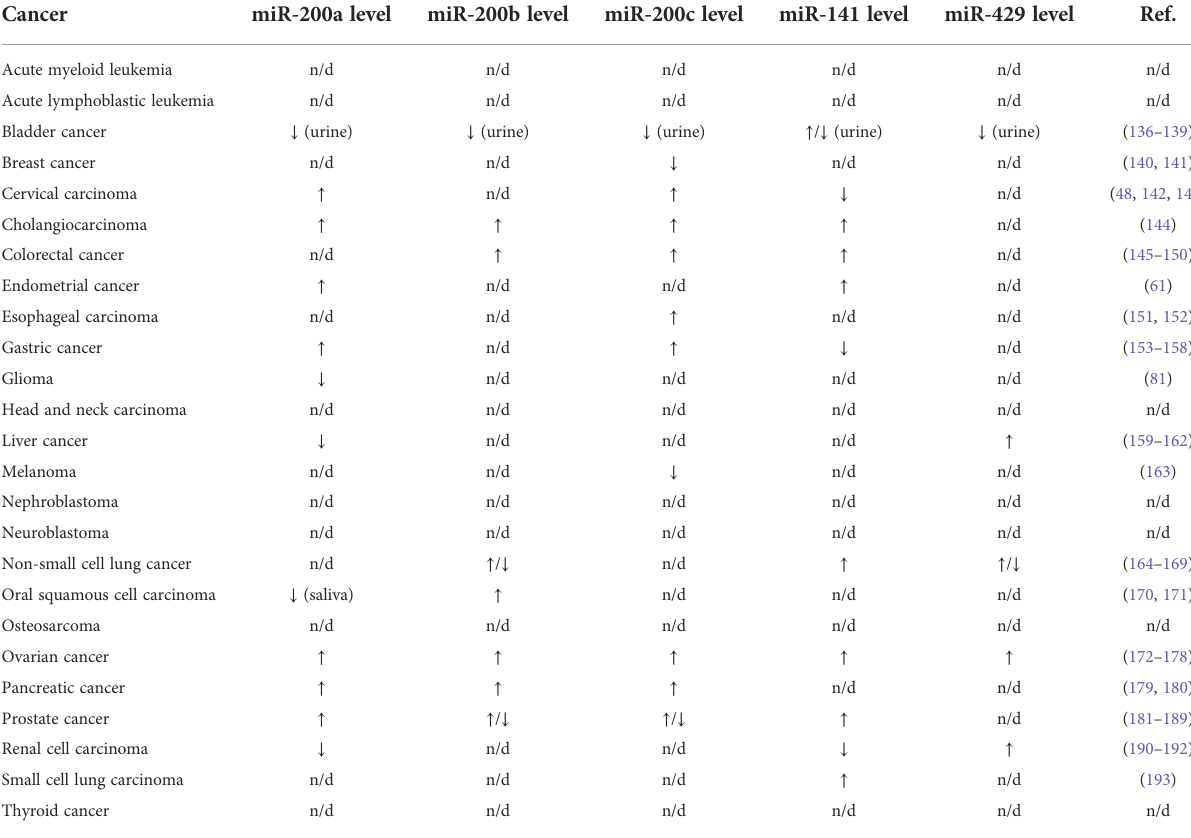
TABLE 2 The level of miR-200 family members in the serum, urine or saliva of patients with different types of cancer.